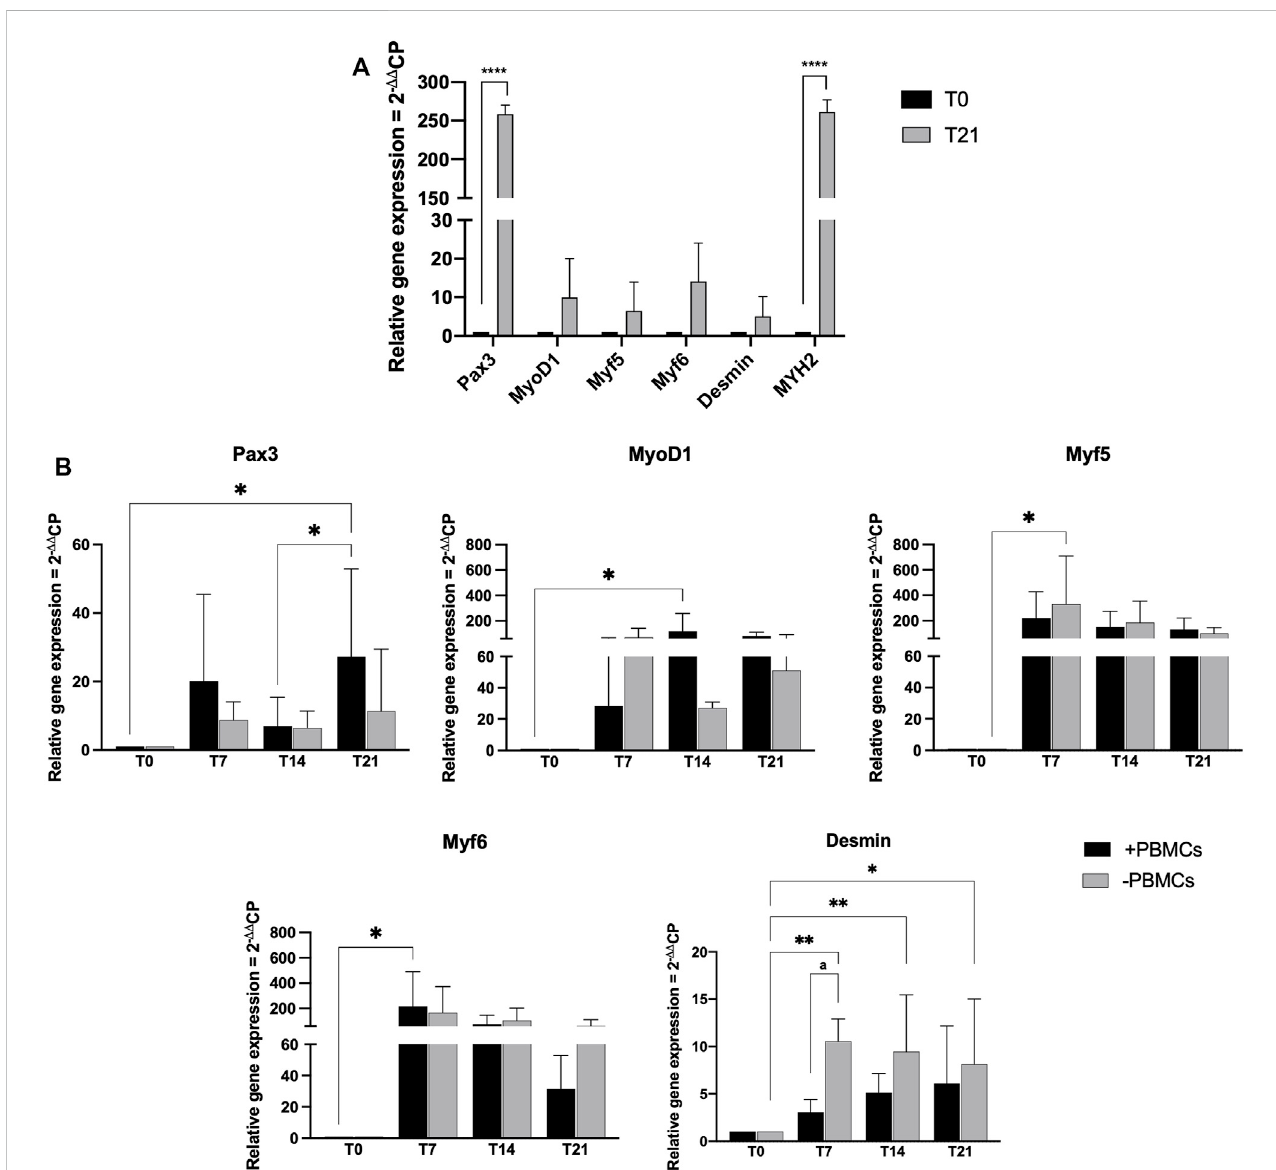
FIGURE 5 Gene expression pro fi ling for myogenic markers by quantitative RT-PCR of h SkMs (A) and of h BM-MSCs- h SkMs-PBMCs (B) , both within 3D fi brin scaffold. mRNA levels of myogenic markers ( Pax3 , MyoD1 , Myf5 , Myf6 and Desmin ) were assayed by qRT-PCR at day 7, 14 and 21 of culture. Relative quanti fi cation of each mRNA gene expression normalized to endogenous GAPDH (internal control) was calculated using the 2 − ΔΔ Ct method and presented as foldchangeover h SkMsatday0 (A) andover h BM-MSCsatday0 (B) ,selectedasacontrol.Allexperimentswereperformedinbiologicaltriplicates(N=3) and each experimentin technical triplicates. *, signi fi cant compared to day 0(T0); a, signi fi cant comparison between ± PBMCsat day 7.* p < 0.05; ** p < 0.01; **** p <